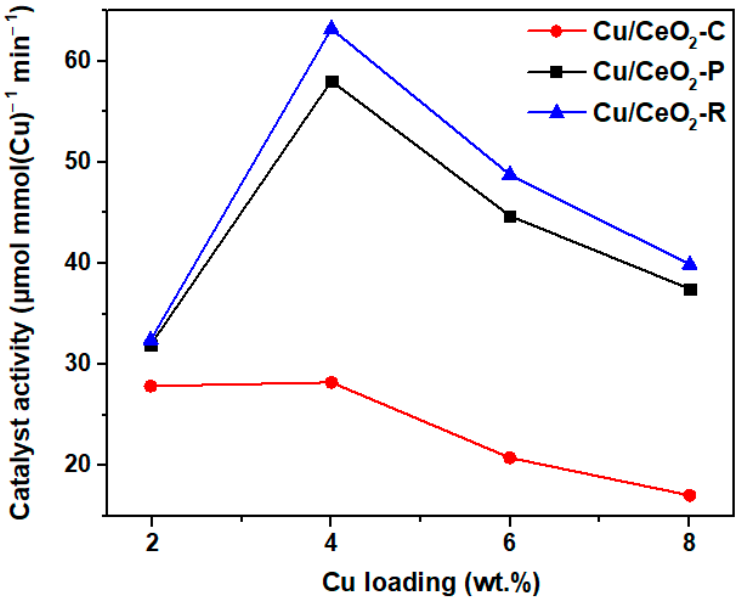
Figure 12. N 2 O decomposition rate of CuO x /CeO 2 samples of different morphology at 375 °C. Adapted from Reference [112]. Copyright© 2015, American Chemical Society.